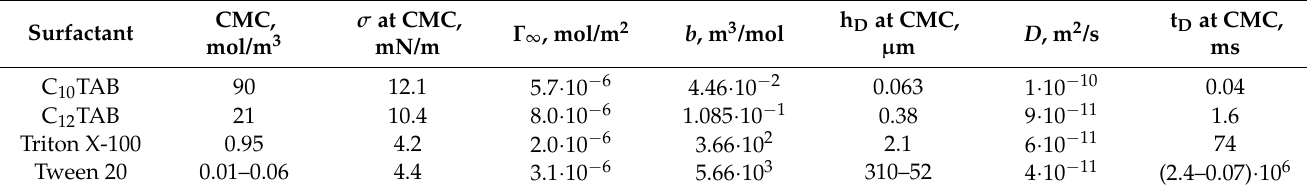
Table 2. Properties of surfactants